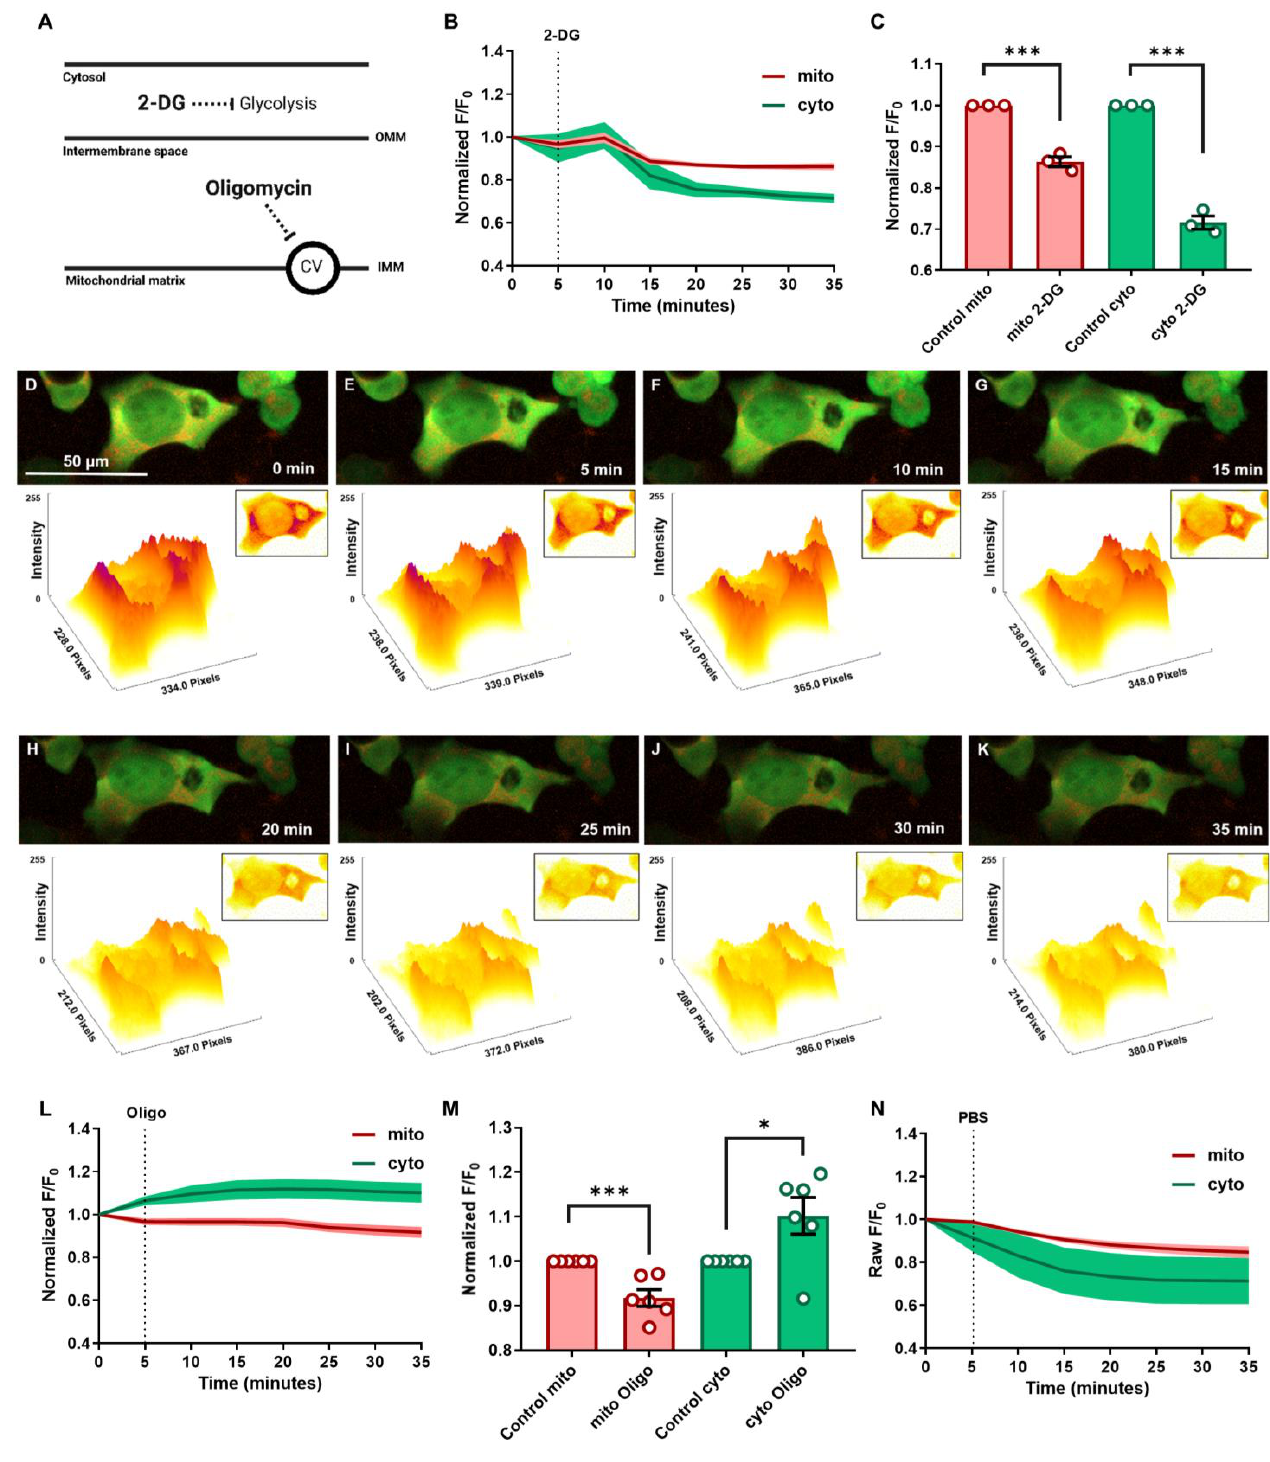
Figure 3. Spatiotemporal ATP dynamics in mitochondria and cytosol can be evaluated in real time using smacATPi after treatment with glycolytic and ATP synthase inhibitors. ( A ) Illustration of the inhibitory effect of 2-deoxyglucose (2-DG) on glycolysis in the cytosol and oligomycin on Complex V of the electron transport chain within the inner mitochondrial membrane. ( B , C ) The effect of 2- DG on the fluorescent intensity of ATP in mitochondria (red) and cytosol (green) on cultured HEK293T cells was graphed over time, pre- and post-drug administration. ( C ) Maximal changes of